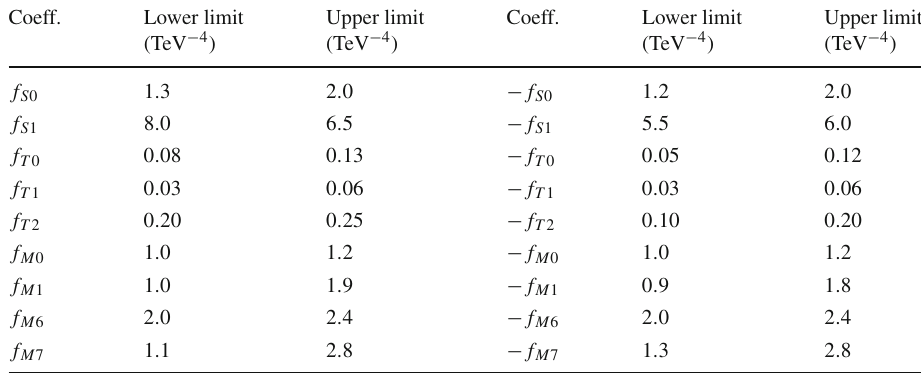
Table 1 Estimated lower